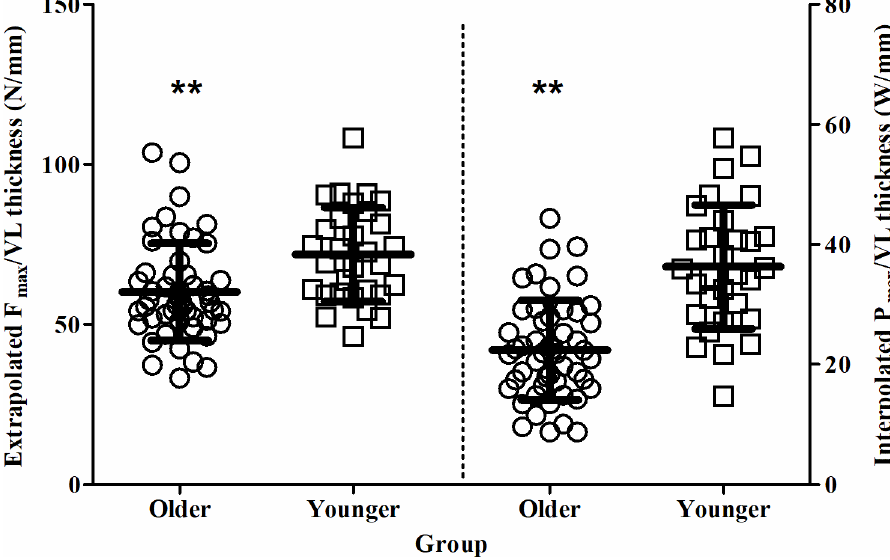
Fig 2. Relative force and power are significantly lower in healthy older individuals than younger individuals. Mean ± SD extrapolated peak force (F max :VL) and interpolated peak power (P max :VL) relative to vastus lateralis muscle thickness for 65–80 vs 20–35 yr olds. The older individuals are represented by circles and the younger individuals by squares. (cid:3)(cid:3) denotes significant difference between age groups ( P <